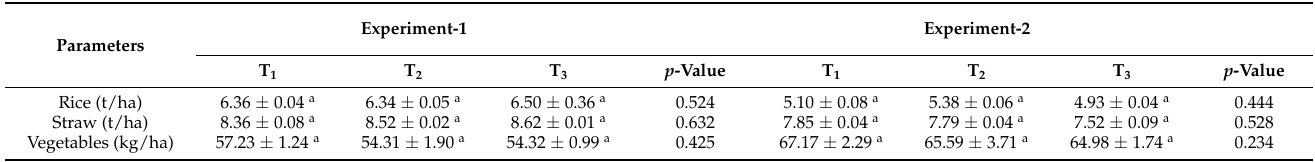
Table 4. Comparison of rice, straw and vegetable production of the culture systems (1 ha rice field and 120 days of experimental duration).